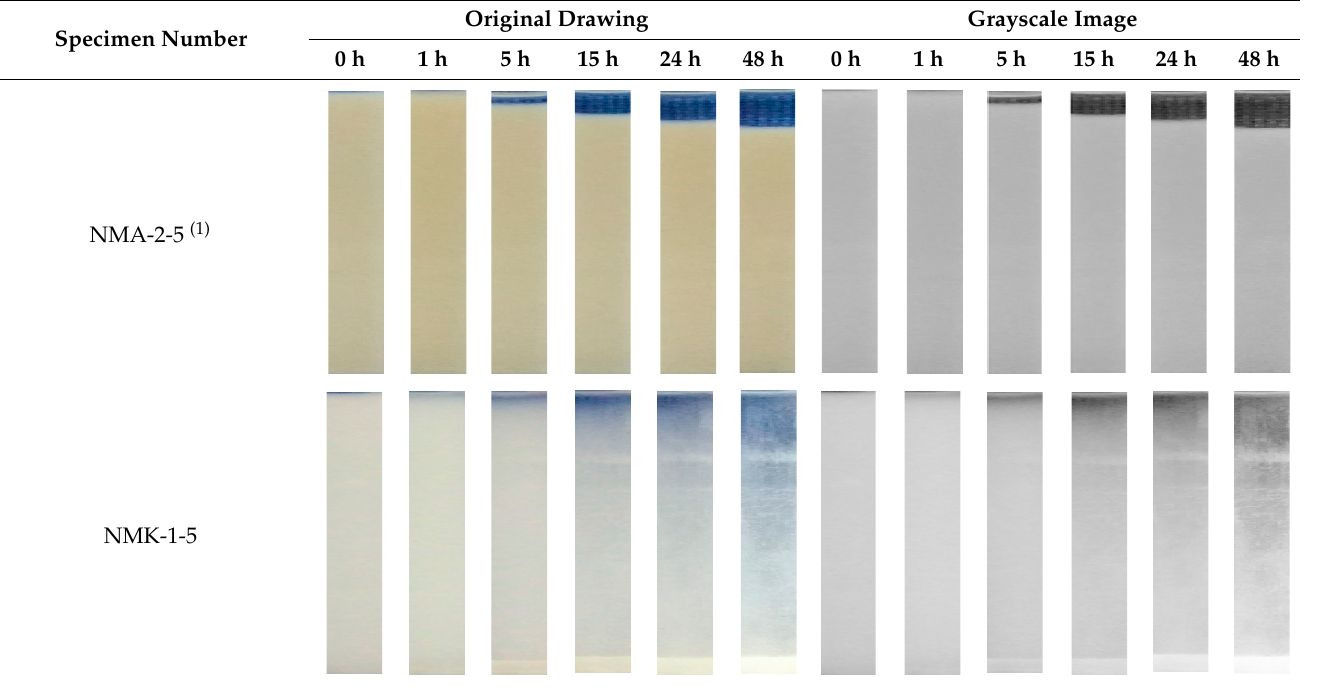
Specimen Number